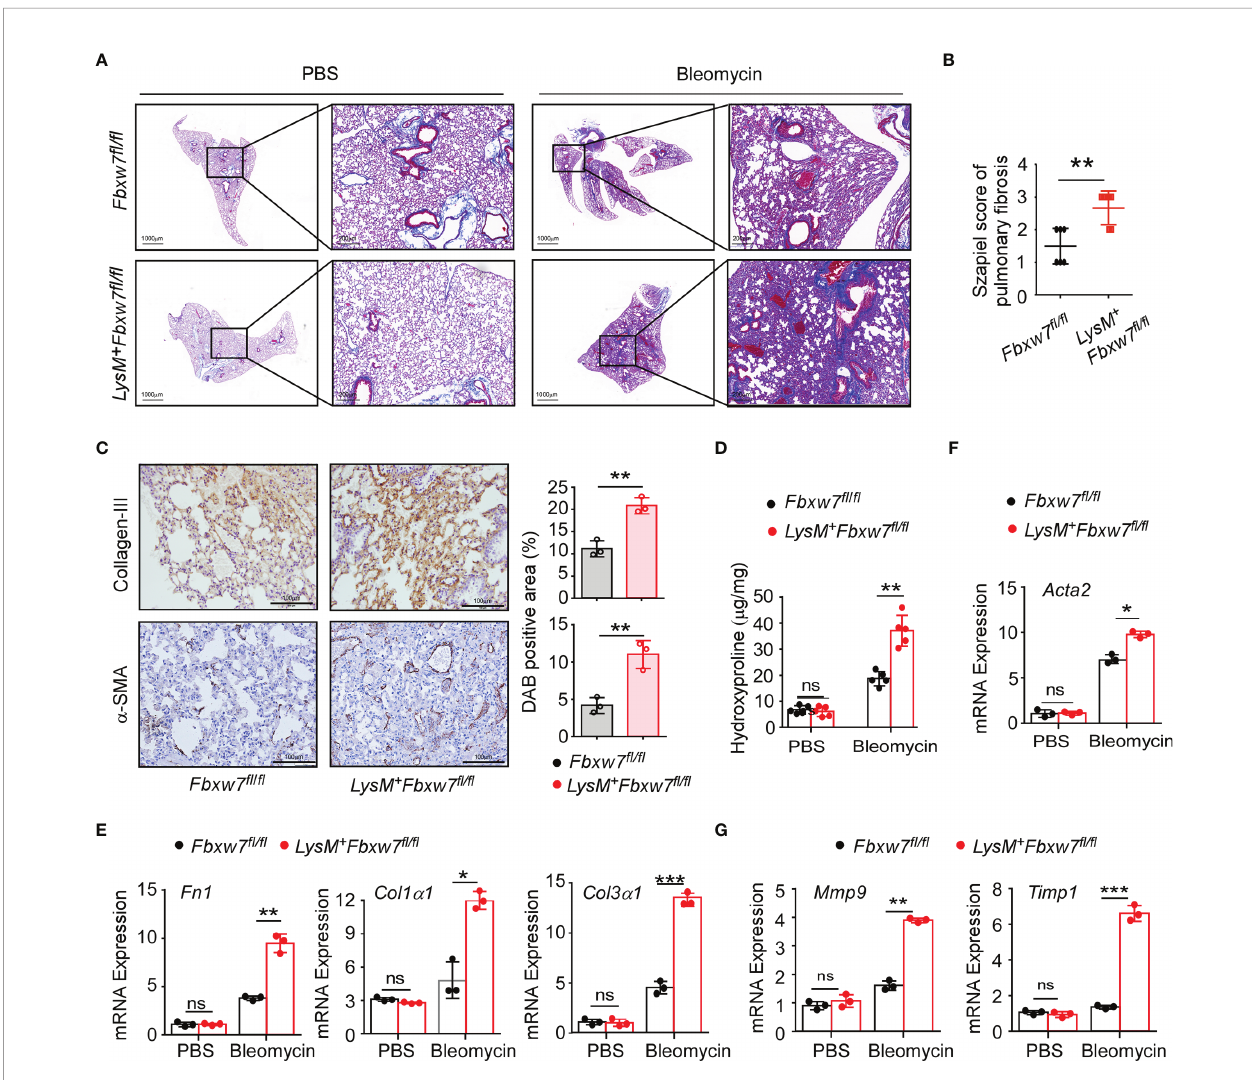
FIGURE 2 | LysM + Fbxw7 fl / fl mice show aggravated pulmonary fi brosis. Fbxw7 fl / fl and LysM + Fbxw7 fl / fl mice were administered bleomycin by direct endotracheal injection to induce pulmonary fi brosis. Three weeks later, lung tissues were isolated for Masson staining and RT-PCR analysis. (A) Masson staining of collagen fi ber, scale bars 1000 m m (whole pulmonary section), and 200 m m (detail) and sapiel score of pulmonary tissue (B) obtained from Fbxw7 fl / fl and LysM + Fbxw7 fl / fl mice. (C) Representative collagen III and a -SMA immunohistochemical staining of lung tissues obtained from Fbxw7 fl / fl and LysM + Fbxw7 fl / fl mice after 21 days of bleomycin- induced lung injury, scale bars 100 m m. Comparison of DAB staining intensity (Image J) among the groups is shown. Quanti fi cation of hydroxyproline contents (D) and relative mRNA expression of collagen genes (E) , Acta2 gene ( a -SMA) (F) , and matrix metalloproteinases (G) in the lungs from Fbxw7 fl / fl and LysM + Fbxw7 fl / fl mice after bleomycin treatment for 21 days. Data are expressed as mean ± SD of biological duplicates (n ≥ 3) and are the representative of three independent experiments. P values were obtained using two-tailed Student ’ s t test. * P < 0.05, ** P < 0.01, *** P < 0.001, ns, not signi fi